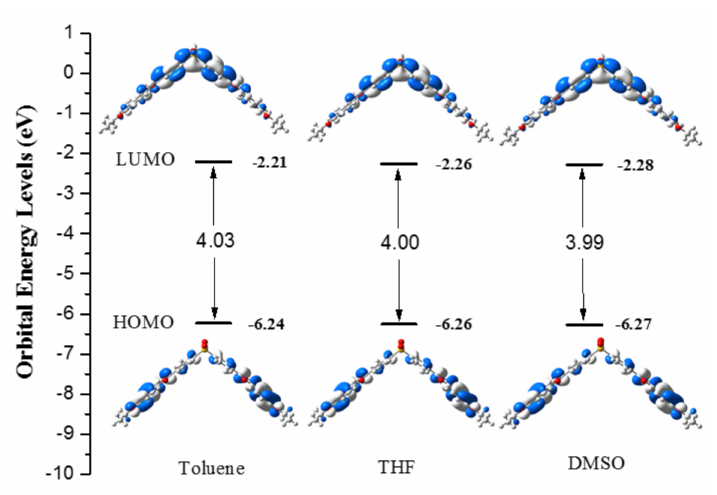
Figure 5. Electron density contours and orbital energies calculated for the HOMO and LUMO of 1a at the Beck3LYP/DZP level in toluene, THF and DMSO.